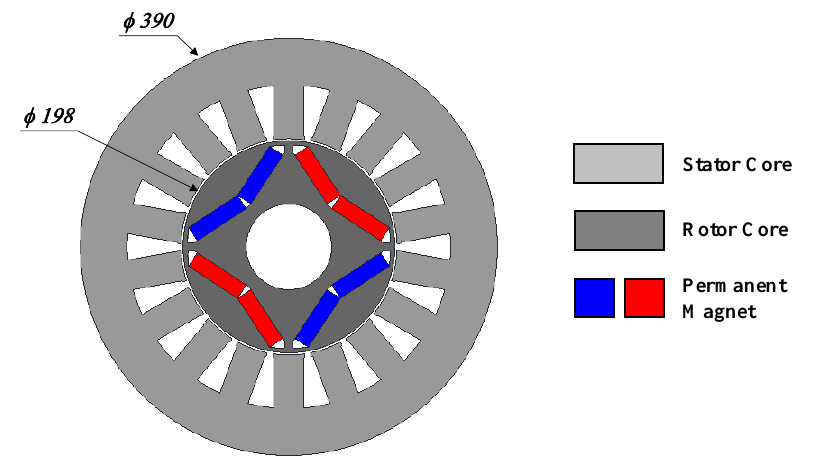
Figure 3. Cross-sectional view of the initial design.